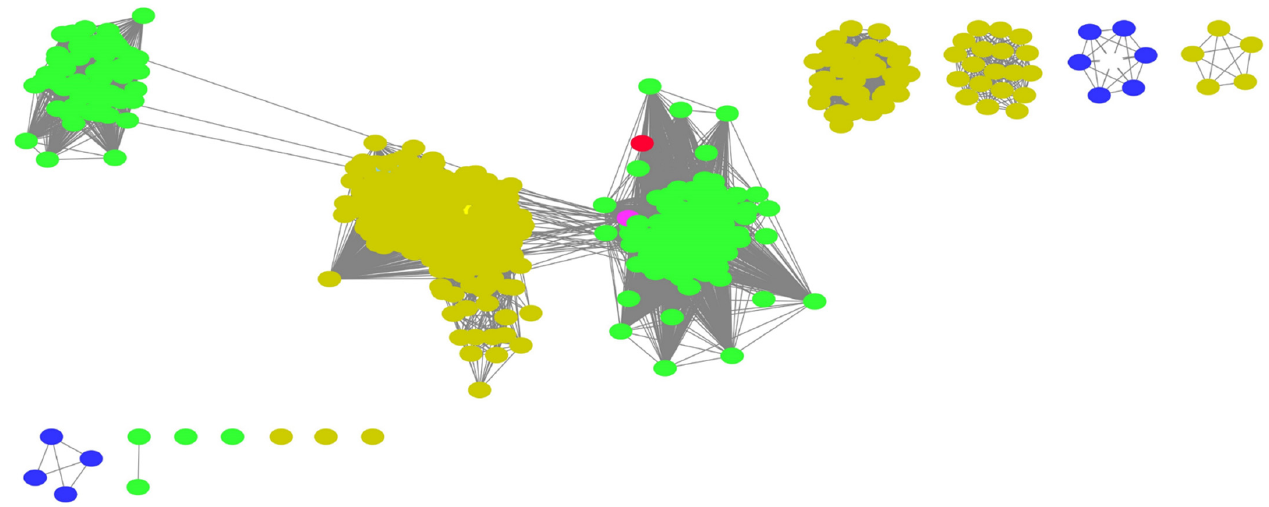
Figure 5. SSN generated using OAC amino acid sequence as a template with 40% sequence identity using EFI-EST webtool [46]. Green nodes represent sequences from plant species, yellow from bacterial species and dark purple from other Eukaryota species. OAC reference sequence is colored red. Uncharacterized sequence from M. polymorpha is colored magenta.